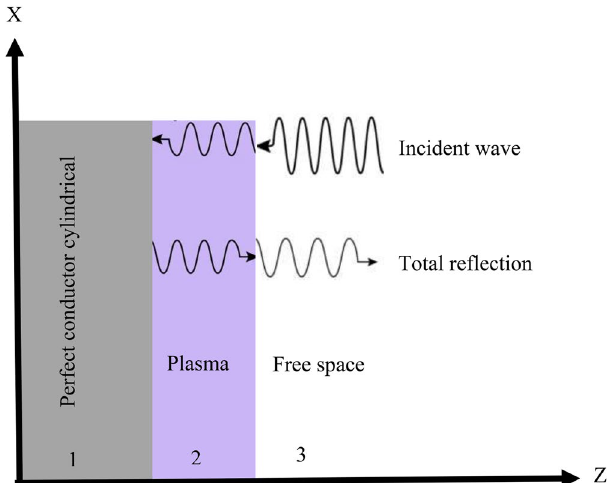
Figure 5. Schematic diagram of microwave reflection in the plasma.